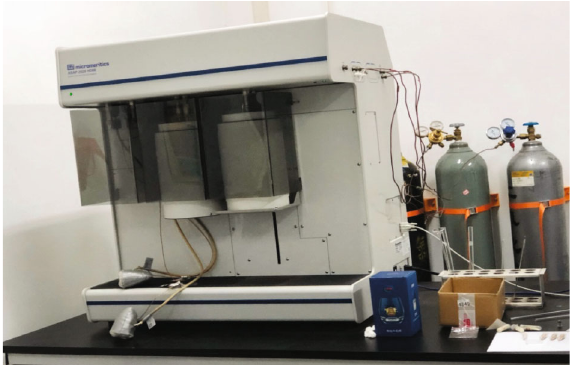
Figure 2: ASAP-2000 automatic surface and aperture